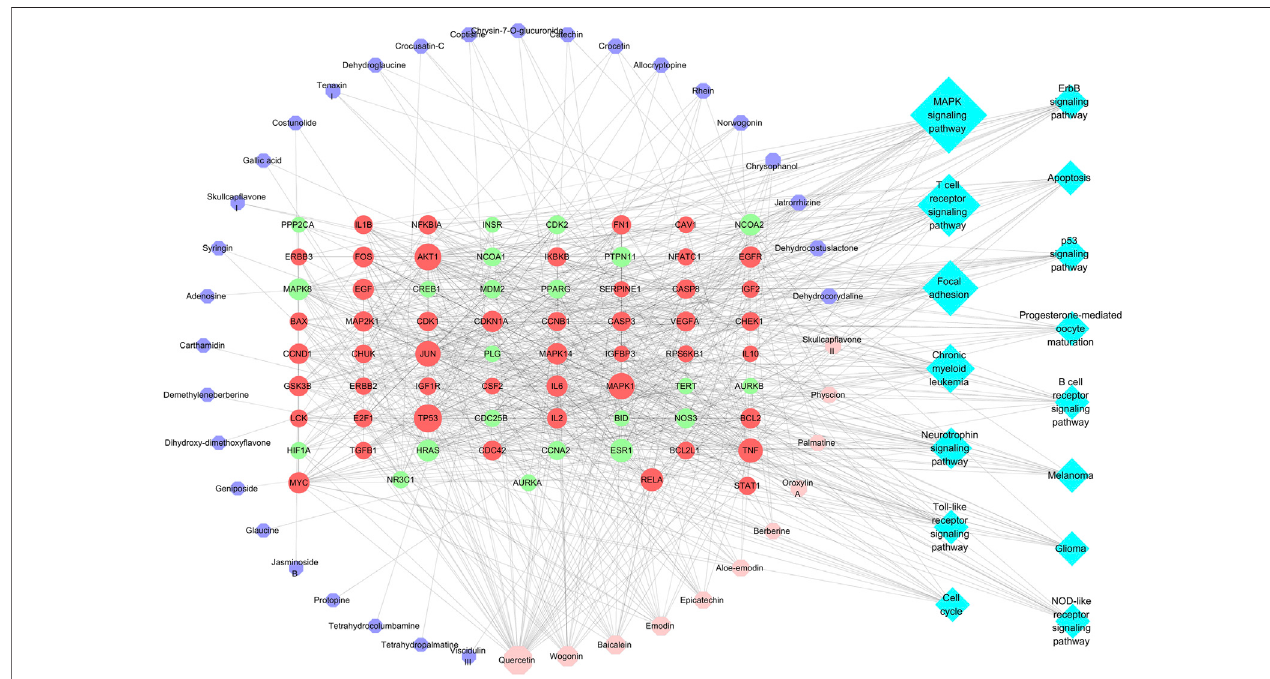
FIGURE 4 | Compound-target-pathway network (Pink octagon represents the key compound; purple octagon represents common compound; red circles represents key target; green circles represents common target; blue diamond represents pathway. It ’ s a positive proportional relationship that between the node size and the